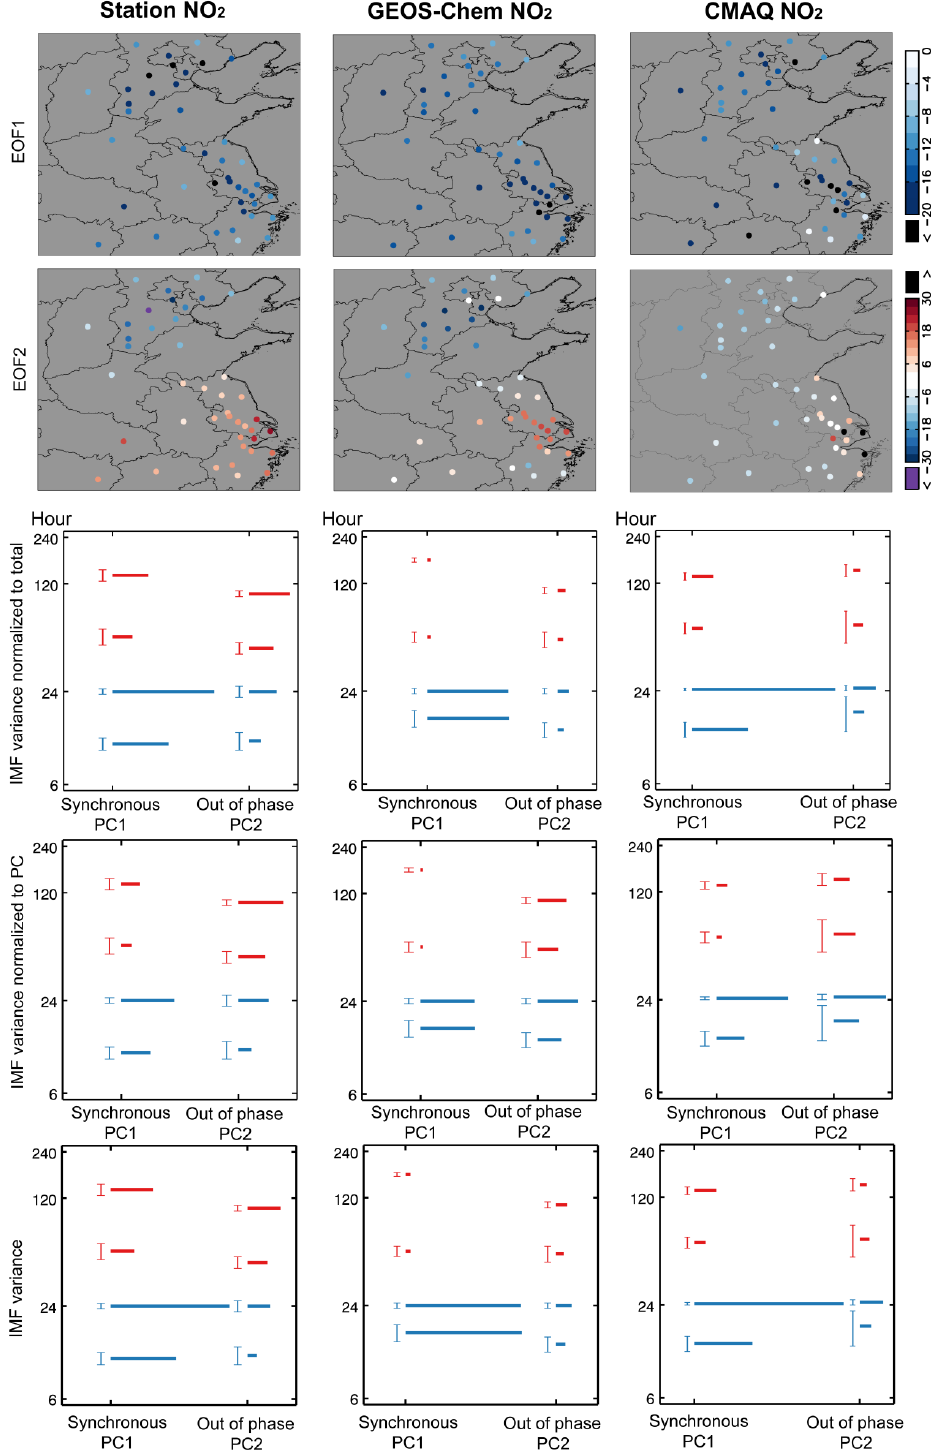
Figure 10. EOF–EEMD–HT–MSA results for observed, GEOS-Chem, and CMAQ NO 2 . See Sect. 4.2 for detailed